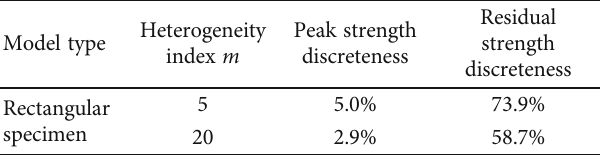
Figure 9: Simulation results of the rectangular specimen when m = 20 . Table 4: Strength discreteness of rock rectangular